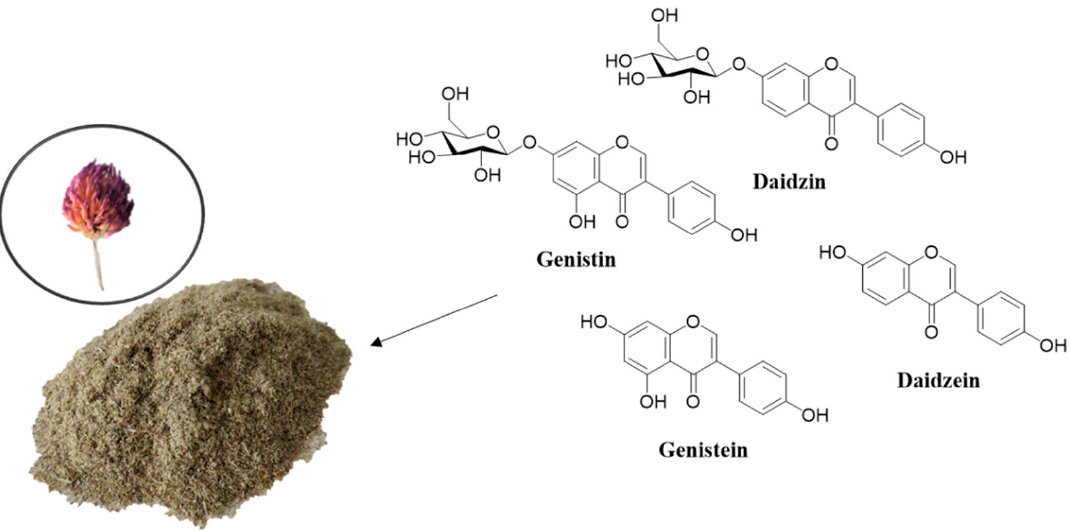
Figure 1. Milled red clover flower buds (0.5 mm) and the main isoflavones found in its extracts.